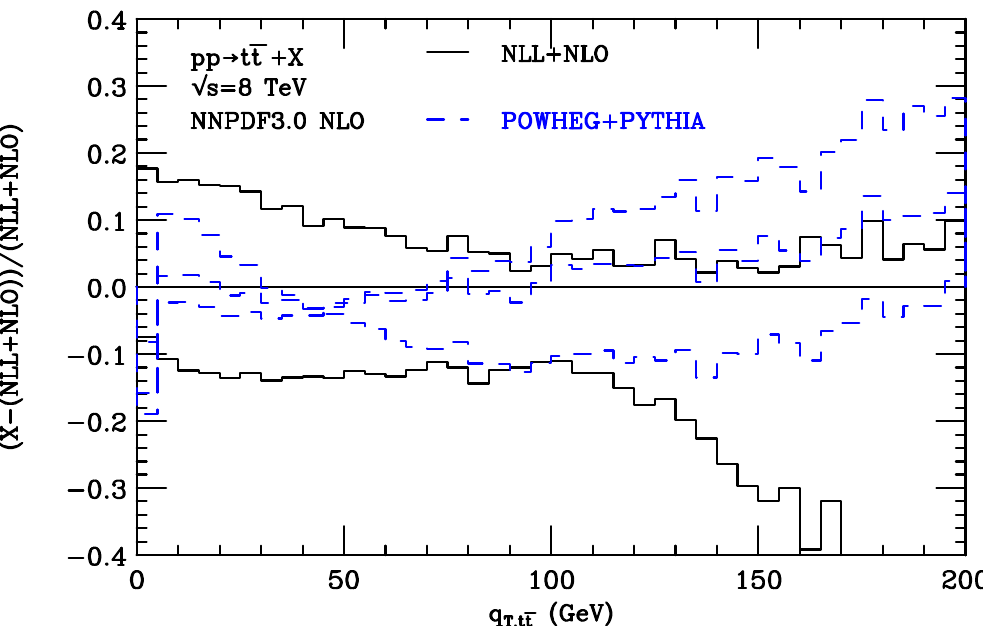
Figure 10. Fractional difference of the POWHEG+PYTHIA results (dashed) with respect to the NLL+NLO result at central scales ( µ F = µ R = Q = m t ). The results refer to the differential cross section dσ/dq T of t ¯ t pairs at √ s = 8 TeV. The POWHEG+PYTHIA results are presented for three different values of h damp , h damp = m t / 2 , m t , 2 m t , at fixed µ F = µ R = m t . The scale dependence { } of the NLL+NLO results (solid) is also